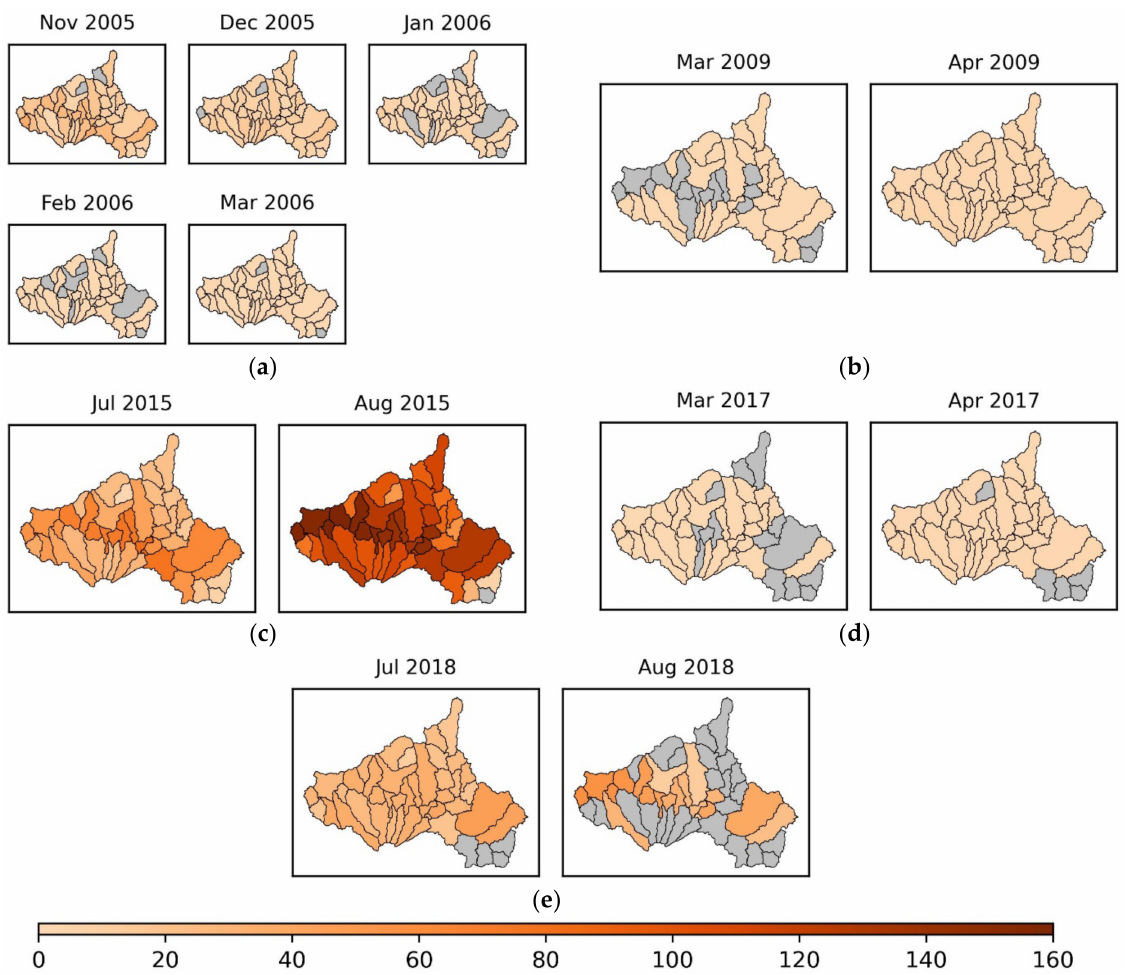
Figure 6. Monthly hydrological drought severity in mm expressed as a deviation from the threshold (baseline scenario): event I ( a ), event II ( b ), event III ( c ), event IV ( d ), event V ( e ). Higher values represent larger deviation (or moisture deficit) and more severe drought.